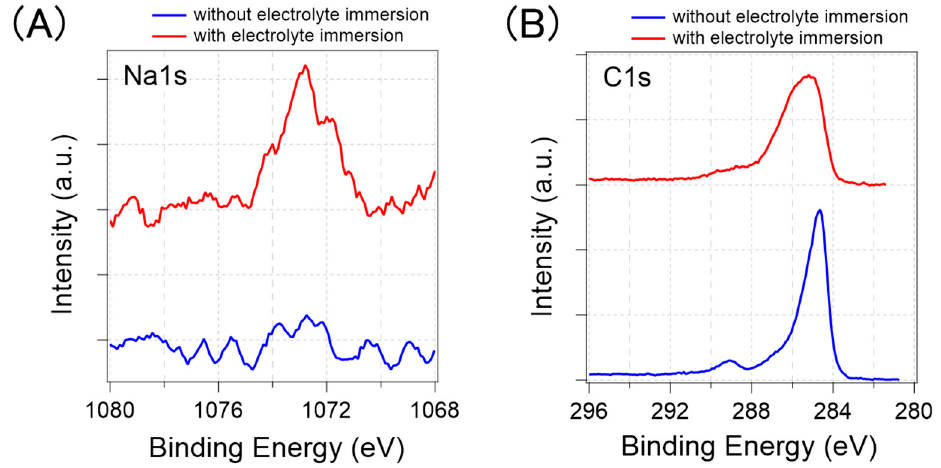
Figure 11. XPS analysis results of graphene with (red line) and without the electrolyte immersion (blue line). ( A ) Na1s peak ( B ) C1s peak.